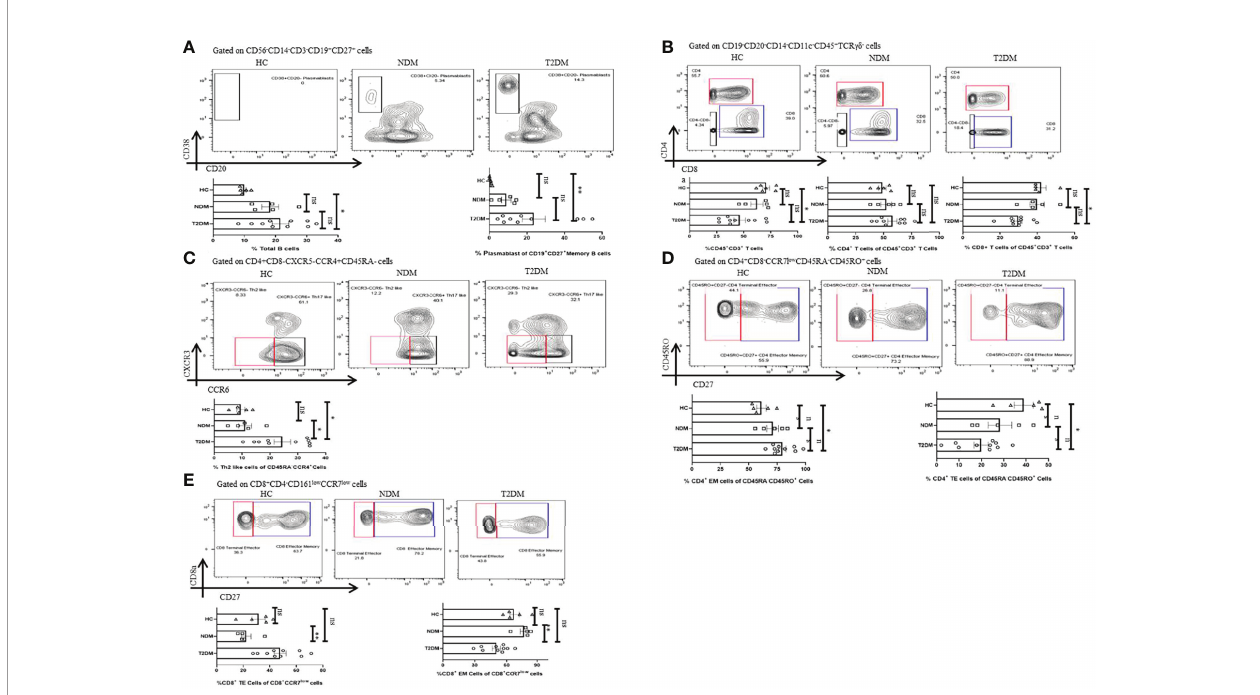
FIGURE 5 | Adaptive immune cells in T2DM and NDM patients. Whole blood from Covid-19 positive T2DM (n = 10), NDM (n = 5), and Covid-19 negative and non- diabetic healthy controls (n = 5) was stained heavy metal tagged antibody and analyzed in a mass cytometer. (A) Representative gating strategy to identify CD38 + CD20 – plasmasblasts. Statistical analysis of percentage of plasmasblasts. (B) Gating strategy to identify CD45 + CD3 + CD4 + and CD45 + CD3 + CD8 + T cells. Statistical analysis for the frequency of CD3 + , CD4 + , and CD8 + T cells. (C) Gating strategy for CD4 + CXCR3 - CCR6 - Th2 like cells. Statistical analysis for the percentage of Th2 like cells. (D) Gating strategy to identify CD4 + TE(CD45RO + CD27 - ) and CD4 + EM cells (CD45RO+CD27 + ). Statistical analysis for the percentages of CD4 + TE and EM cells. (E) Gating strategy to identify CD8 + TE (CCR7 – CD27 - ) and EM(CCR7 - CD27 + ) cells. Statistical analysis for the percentages of the CD8 + TE and EM cells. The Kruskal Wallis Test (non-parametric) with post-hoc Dunn ’ s multiple comparison test was performed. p < 0.05 was considered to be statistically signi fi cant (*), p < 0.01 was considered to be very signi fi cant (**), ns, not signi fi cant. All error bars were